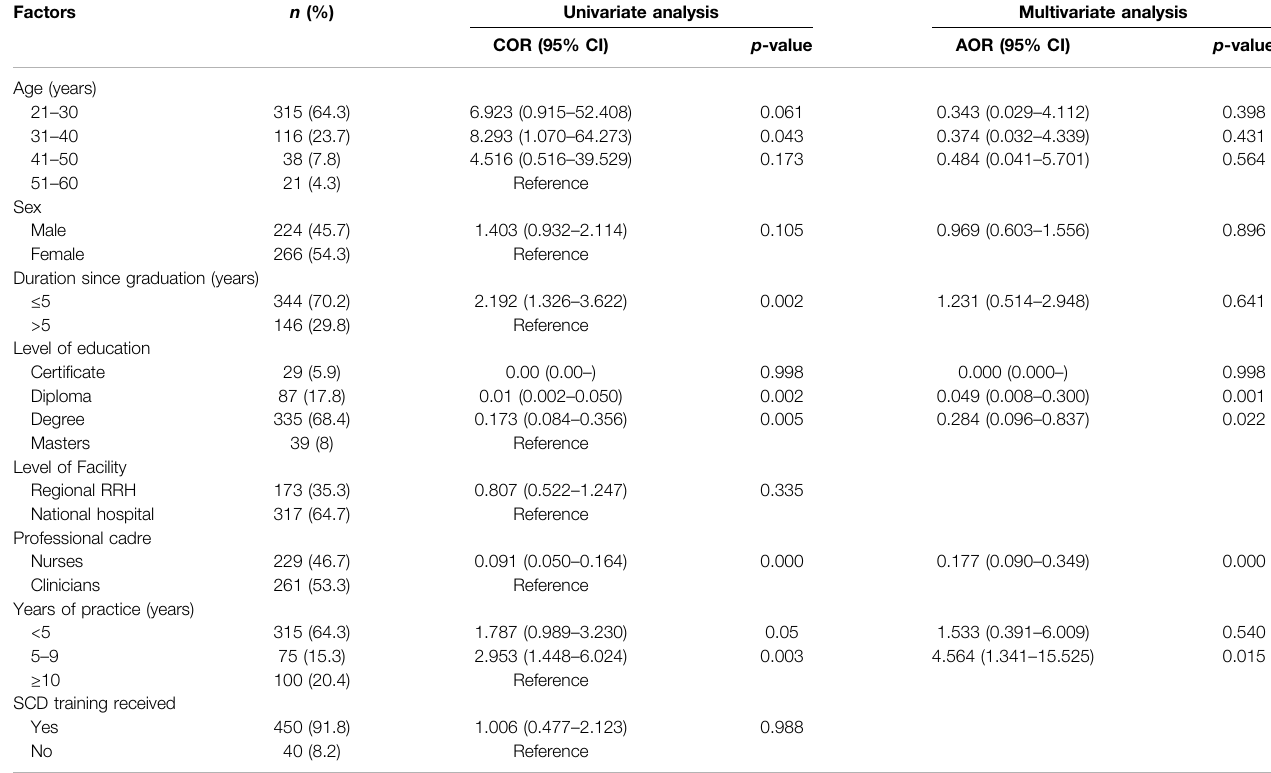
TABLE 2 | Regression analysis of factors in fl uencing knowledge among healthcare workers